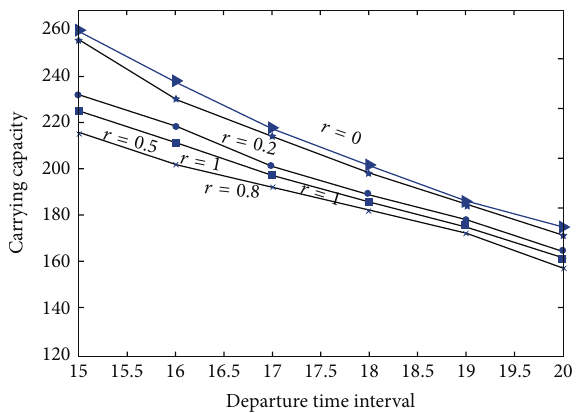
Figure 4: The influence on carrying capacity by departure time interval in different mixture ratio ( 𝑟 represents the ratio of number of the express-train compared with that of the lower-speed train).